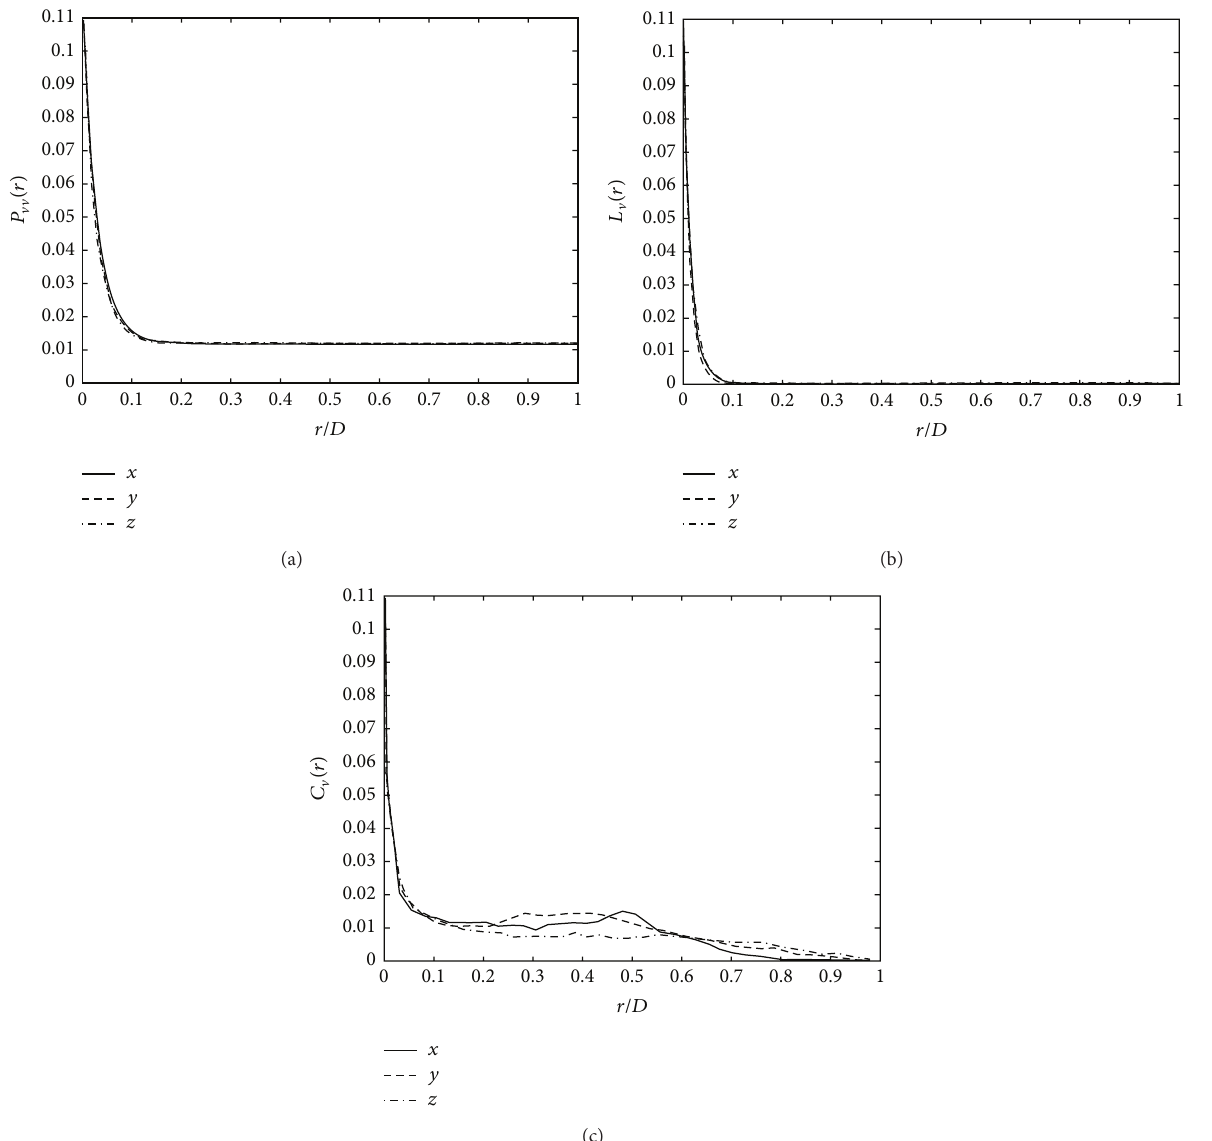
Figure 8: Low-order probability functions for the ROI of the insulating concrete specimen: (a) two-point correlation function, (b) lineal-path function, and (c) two-point cluster function (note: 𝑟 is the distance between two points, and 𝐷 is the length of the specimen